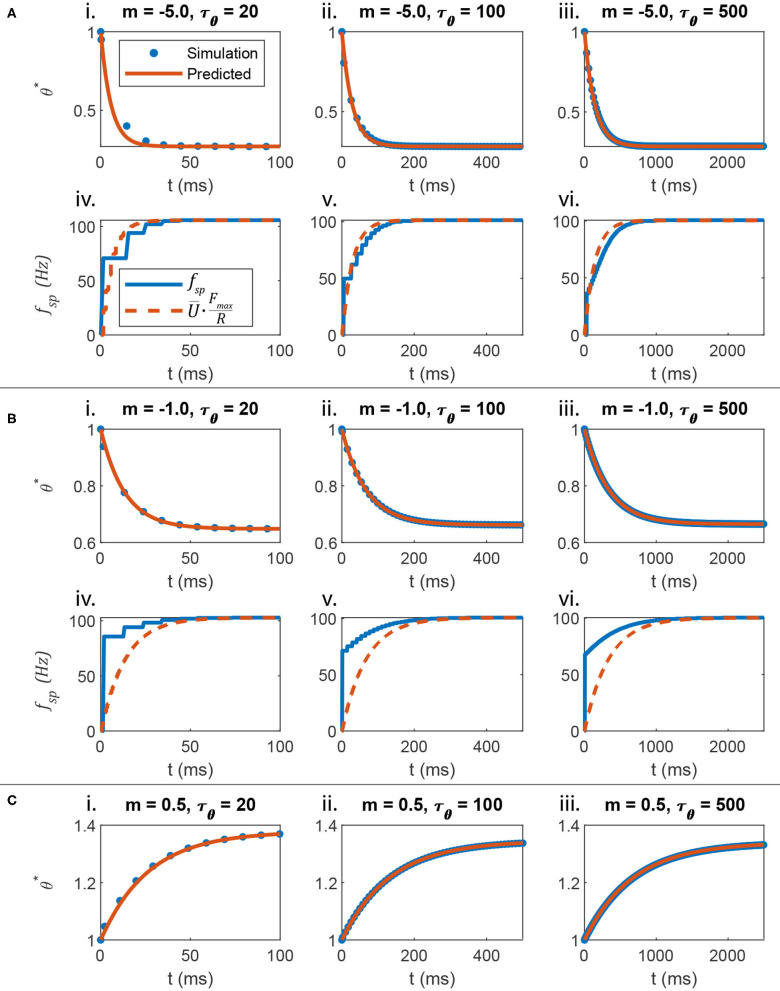
The evolution of the spiking threshold when a spike occurs can be predicted. (A) When the threshold strongly hyperpolarizes in response to membrane voltage depolarization, the transient spiking frequency evolves much like the non-spiking neuron's membrane voltage. (B) When the threshold weakly hyperpolarizes in response to membrane voltage depolarization, the transient spiking frequency evolves at the same rate as a non-spiking neuron's membrane voltage, but the amplitude matches poorly. This is because the spiking neuron's membrane must depolarize strongly before firing even one spike, leading to a large leap in frequency from 0 to a non-zero value. (C) This analysis also applies if the spiking threshold depolarizes in response to membrane voltage depolarization (i.e., m > 0). However, the comparison between fsp and U is not shown because in this case, fsp begins large and decreases over time, rather than beginning small and increasing over time, like U¯.